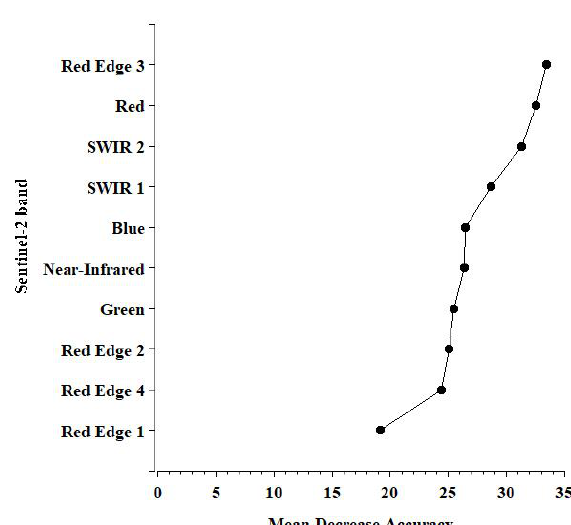
Figure 5. Variable importance plot produced by applying the Random Forest to all the original band reflectance of the postfire Sentinel-2 image